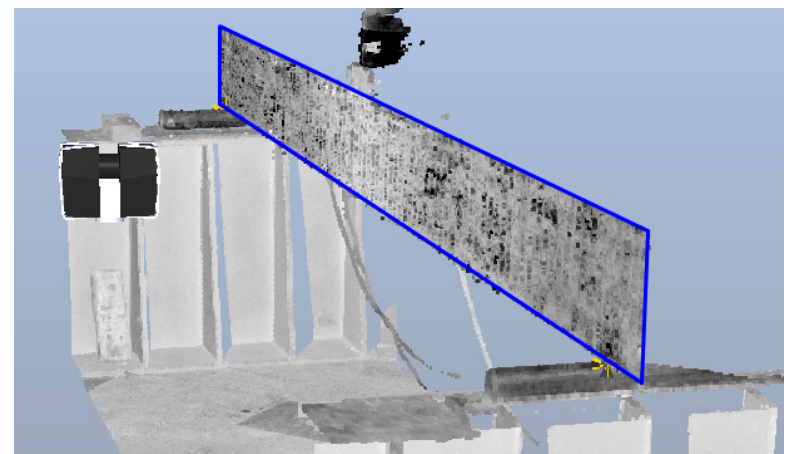
Figure 12. Side plane of the beam after scanning.